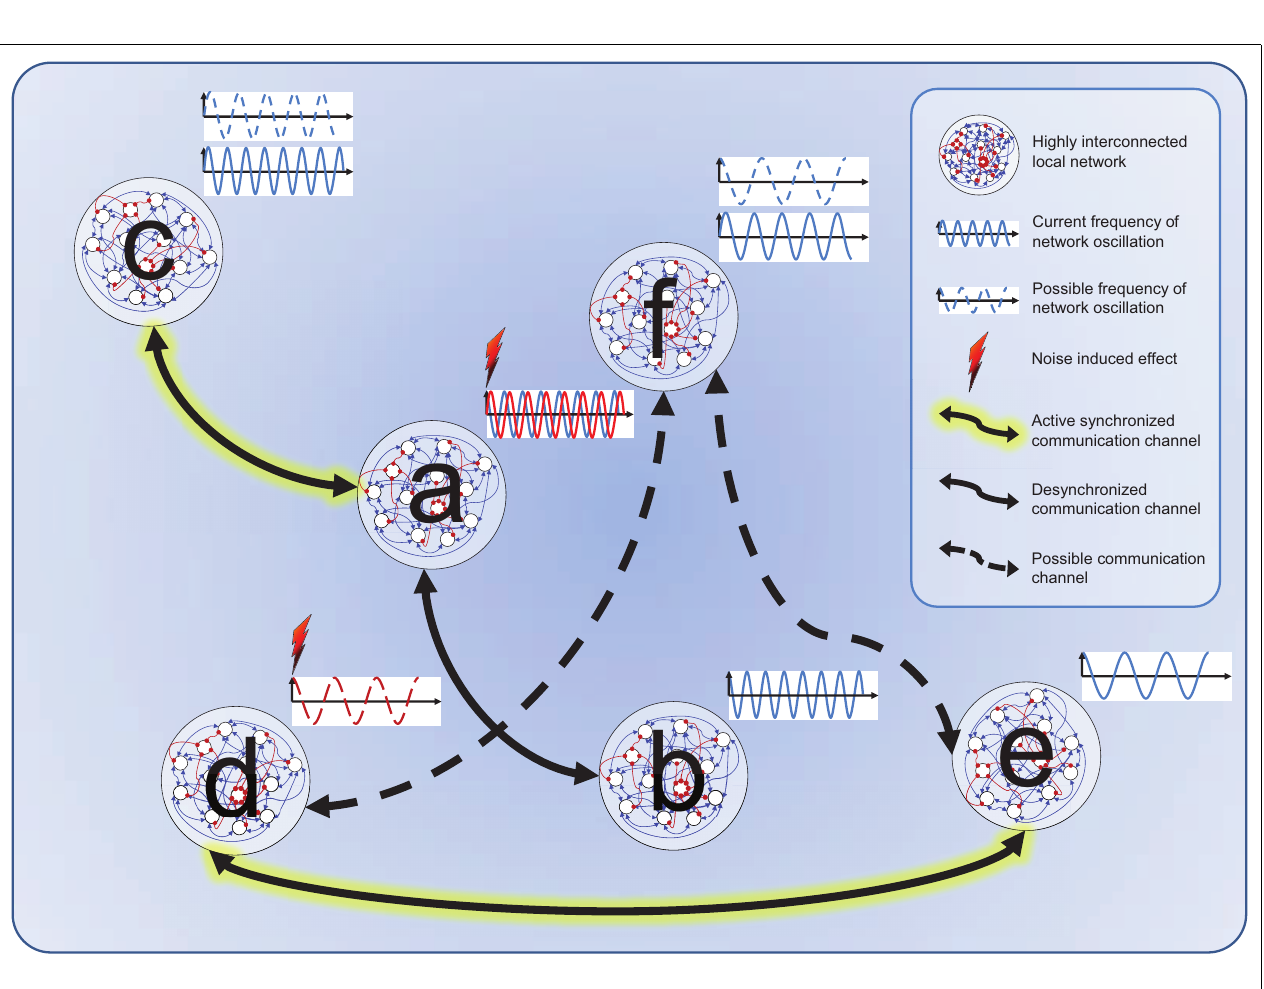
desynchronizing this channel and synchronizing a with c. Noise can also induce oscillation in d synchronizing it with e. F Could principally also synchronize with d and e, but is currently in its different oscillation